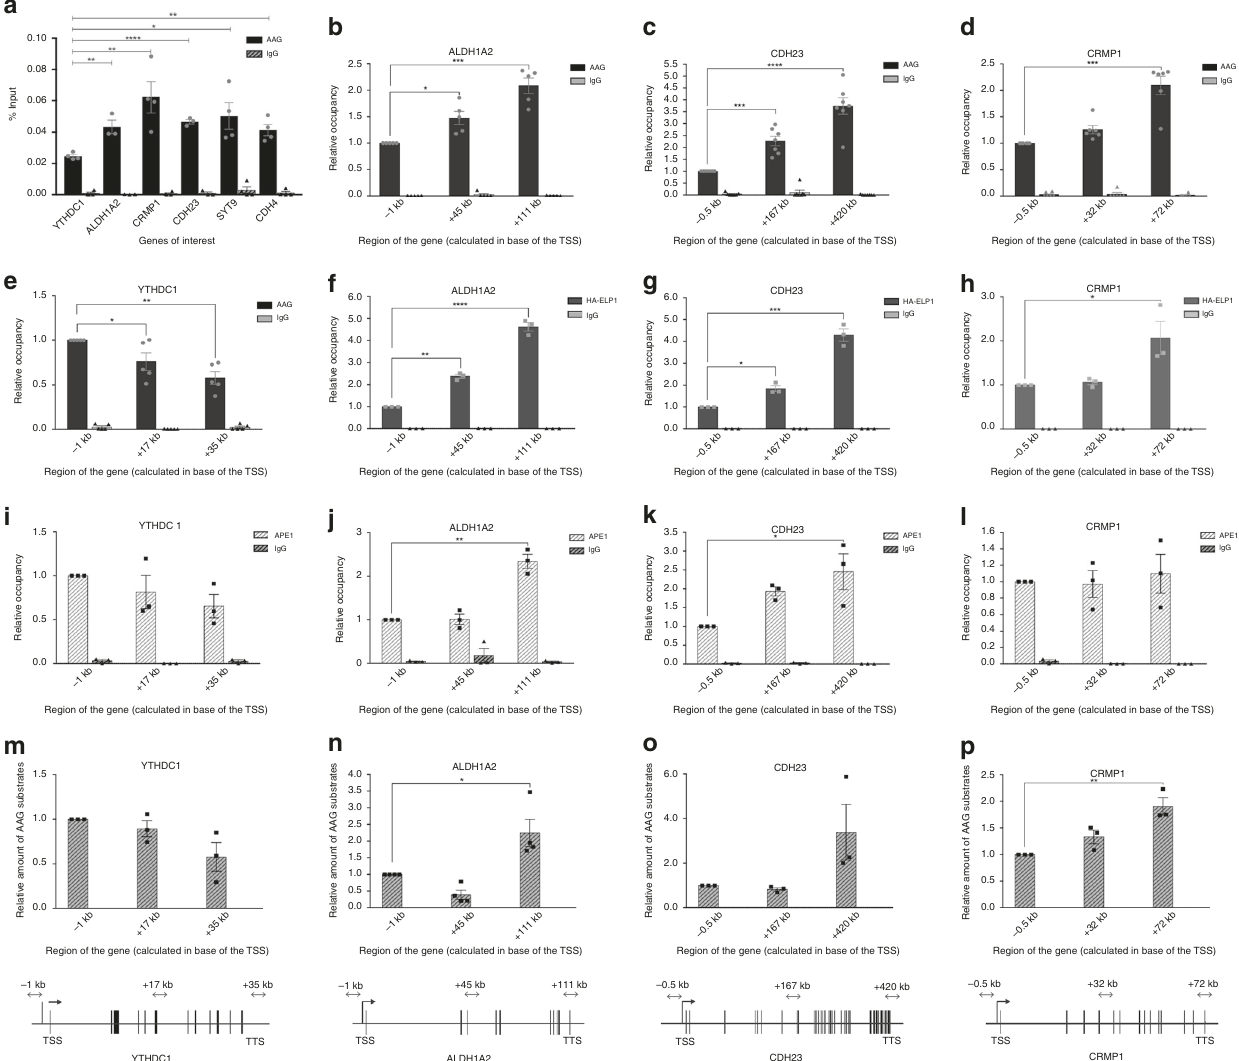
Fig. 4 Elongator, components of AAG-initiated BER and AAG substrates accumulate towards the 3 ′ end of co-regulated genes. a AAG ChIP-qPCR assays in HEK293T WT cells comparing percentage of input at gene bodies of unaffected gene ( YTHDC1 ) and differentially expressed genes ( ALDH1A2, CRMP1, CDH23, SYT9 , and CDH4 ). b – e ChIP-qPCR assays showing relative AAG occupancy in AAG- and ELP1- dependent genes ALDH1A2 ( b ), CDH23 ( c ), CRMP1 ( d ), and unaffected gene YTHDC1 ( e ) in HEK293T WT cells. f – h ChIP-qPCR assays showing relative occupancy of HA-ELP1 in AAG- and ELP1- dependent ALDH1A2 ( f ), CDH23 ( g ), and CRMP1 ( h ) genes in HEK293T HA-ELP1cells. i – l ChIP-qPCR assays showing relative APE1 occupancy in negative control YTHDC1 gene ( i ), and AAG- and ELP1-dependent ALDH1A2 ( j ), CDH23 ( k ), CRMP1 ( l ) genes in HEK293T WT cells. m – p qPCR DNA damage assay showing differences in distribution pattern of aberrant AAG substrates in unaffected gene Y THDC1 ( m ) and genes regulated by AAG and ELP1: ALDH1A2 ( n ), CDH23 ( o ), CRMP1 ( p ) in HEK293T WT cells. Values are shown as relative occupancy: % input of speci fi c gene region, relative to percentage input of promoter region. Error bars indicate mean ± SEM ( n ≥ 3). Two-tailed Student ’ s t -test in a ; one-way ANOVA in b – p ; * p ≤ 0.05, ** p ≤ 0.01, *** p ≤ 0.001, **** p ≤ 0.0001. Source data are provided as Source Data fi